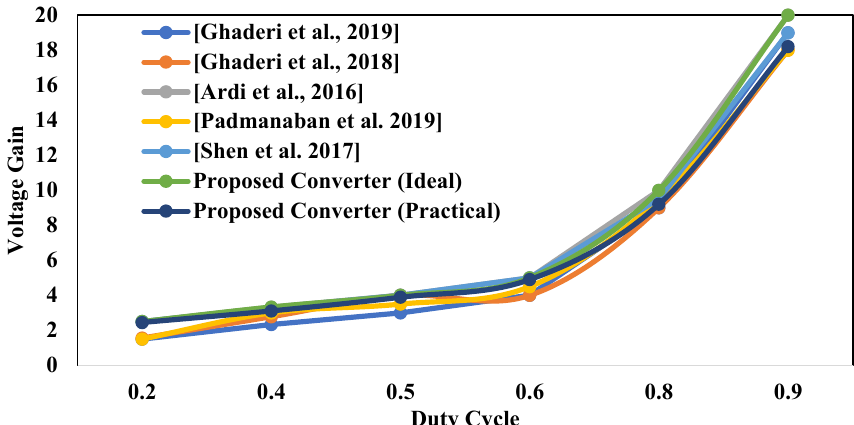
Figure 13. Voltage gain characteristics of various converters.